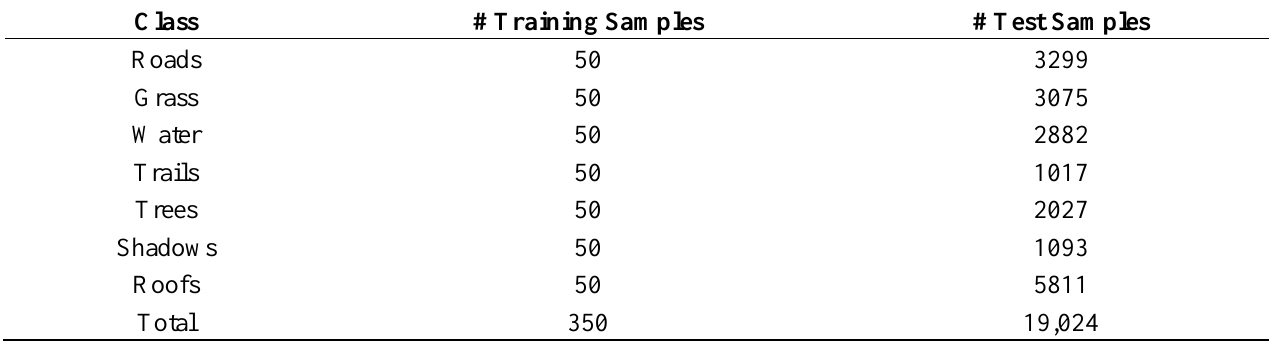
Table 2. Numbers of samples for the Washington DC image.